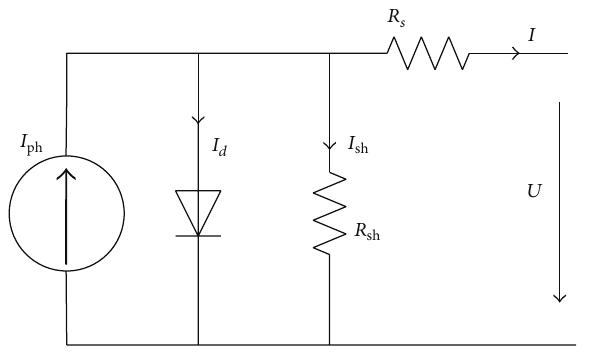
Figure 5: Circuit model of solar cell.